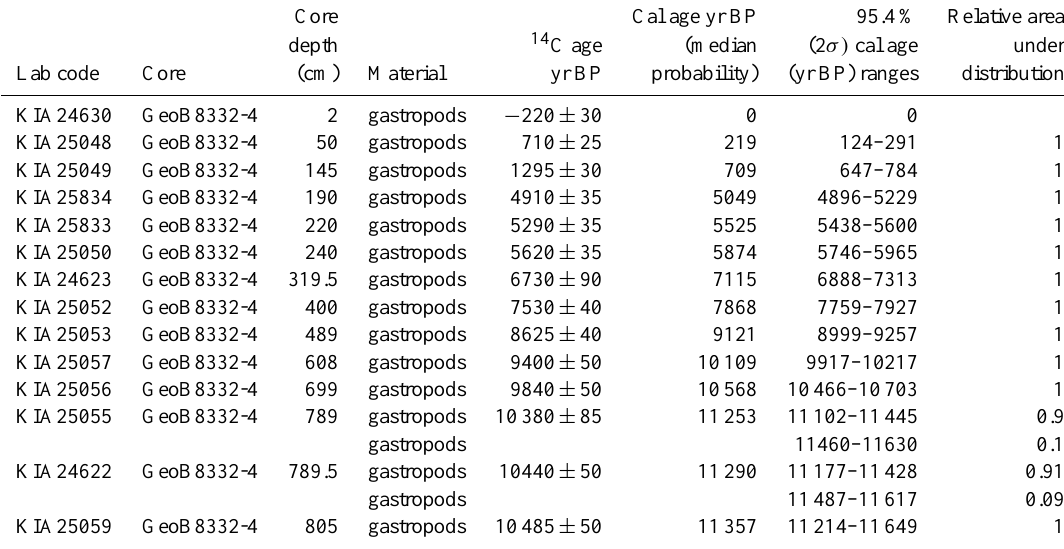
Table 1. Details of the material used to establish an age model for GeoB8332-4. 14 C ages were converted to calendar ages using CALIB software (Stuiver and Reimer, 1993) (version 6.10), Marine data set 2009 (Reimer et al., 2009), and 1 R of 129 ± 19 based on reservoir age of eastern South Atlantic water (Dewar et al., 2012; data retrieved from http://calib.qub.ac.uk/marine as of 5 May 2012). The final age models were established using polynomial (11500–5000yr BP) and linear (0–700yr BP)